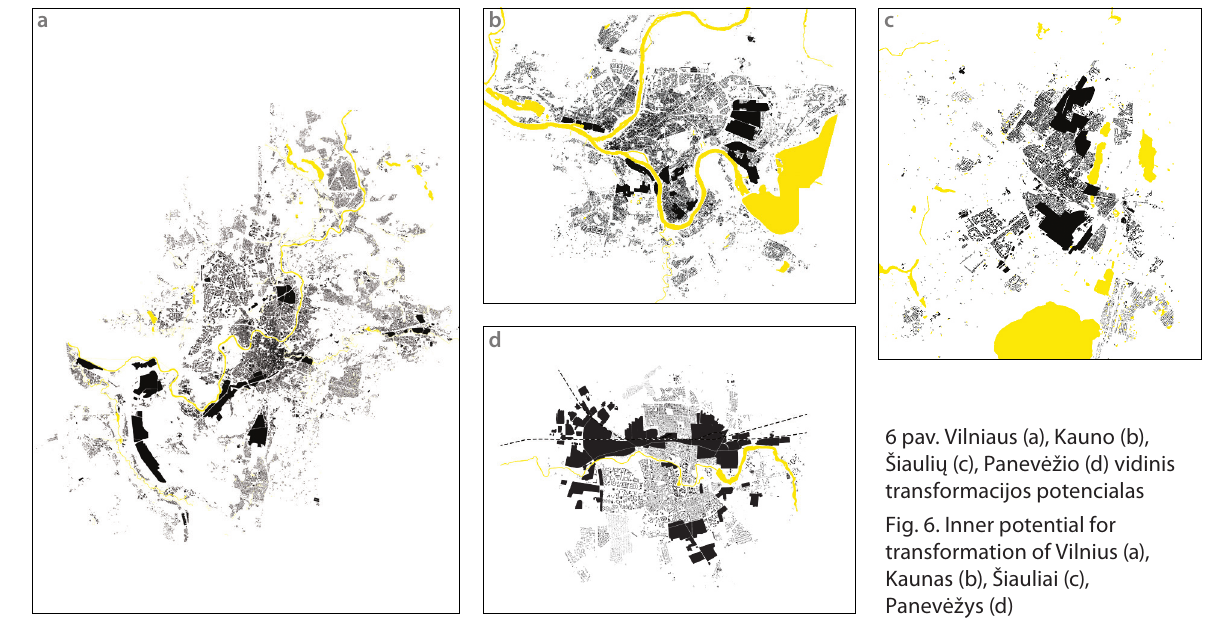
fig. 6. Inner potential for transformation of Vilnius (a), Kaunas (b), Šiauliai (c), Panevėžys